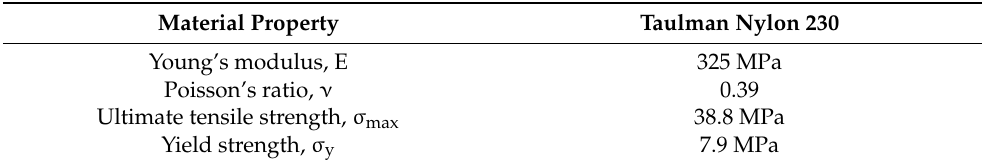
Table 4. Mechanical properties of the 3D-printed Taulman Nylon 230 obtained by tensile testing.